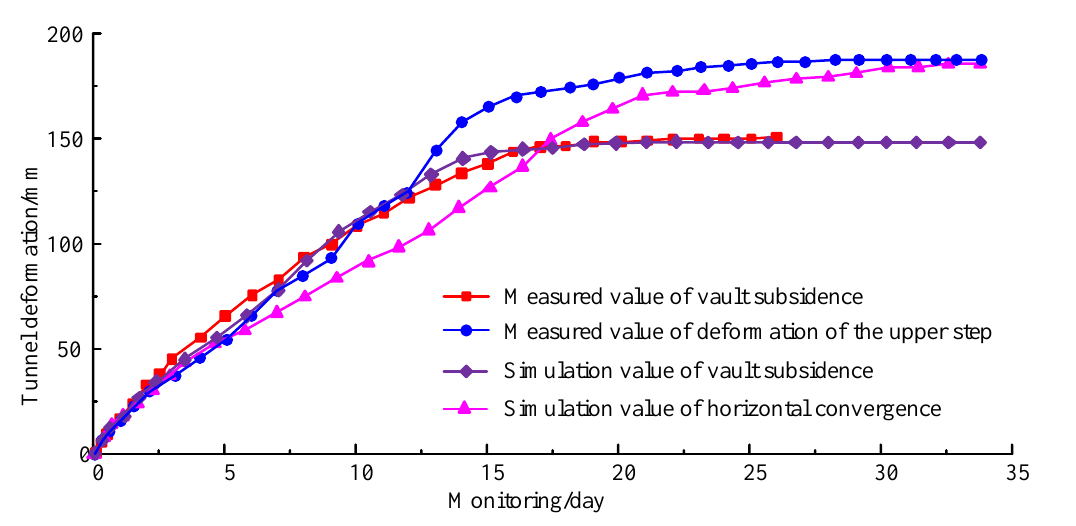
Figure 6. Curves of contrast between the simulation results and measured data.